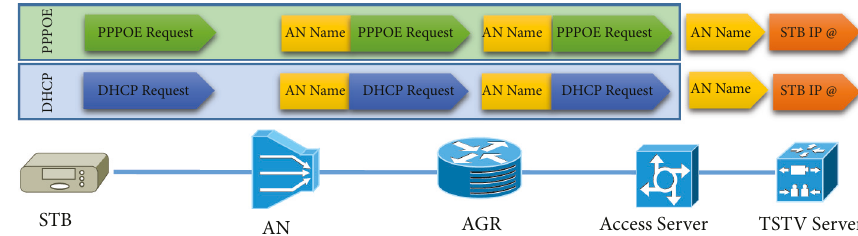
Figure 8: Collecting the STB location information.